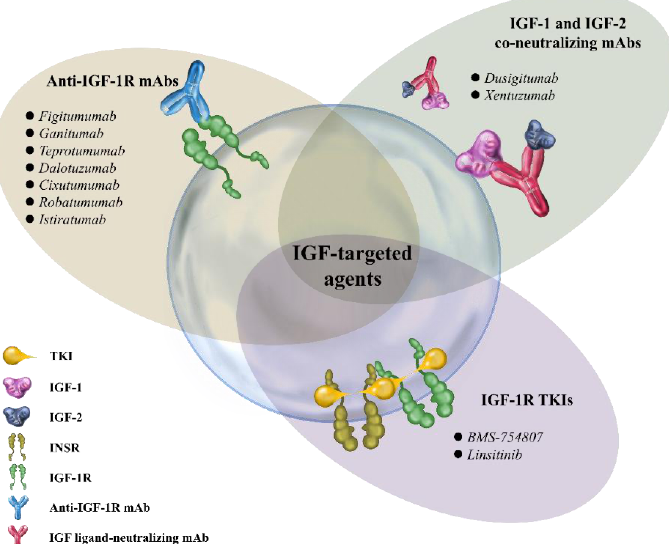
Figure 2. Examples of IGF-targeted agents. Anti-IGF-1R mAbs block ligand – receptor interactions and induce receptor internalization and degradation. Tyrosine kinase inhibitors bind to the receptor tyrosine kinase domain and block the downstream signaling of IGF-1R and INSR. IGF ligand-neu- tralizing mAbs bind to both IGF ligands (IGF-1 and IGF-2), thereby blocking the activation of IGF- 1R and INSR-A. IGF-1R, insulin-like growth factor-1 receptor; mAbs, monoclonal antibodies; TKI, tyrosine kinase inhibitors; INSR, insulin